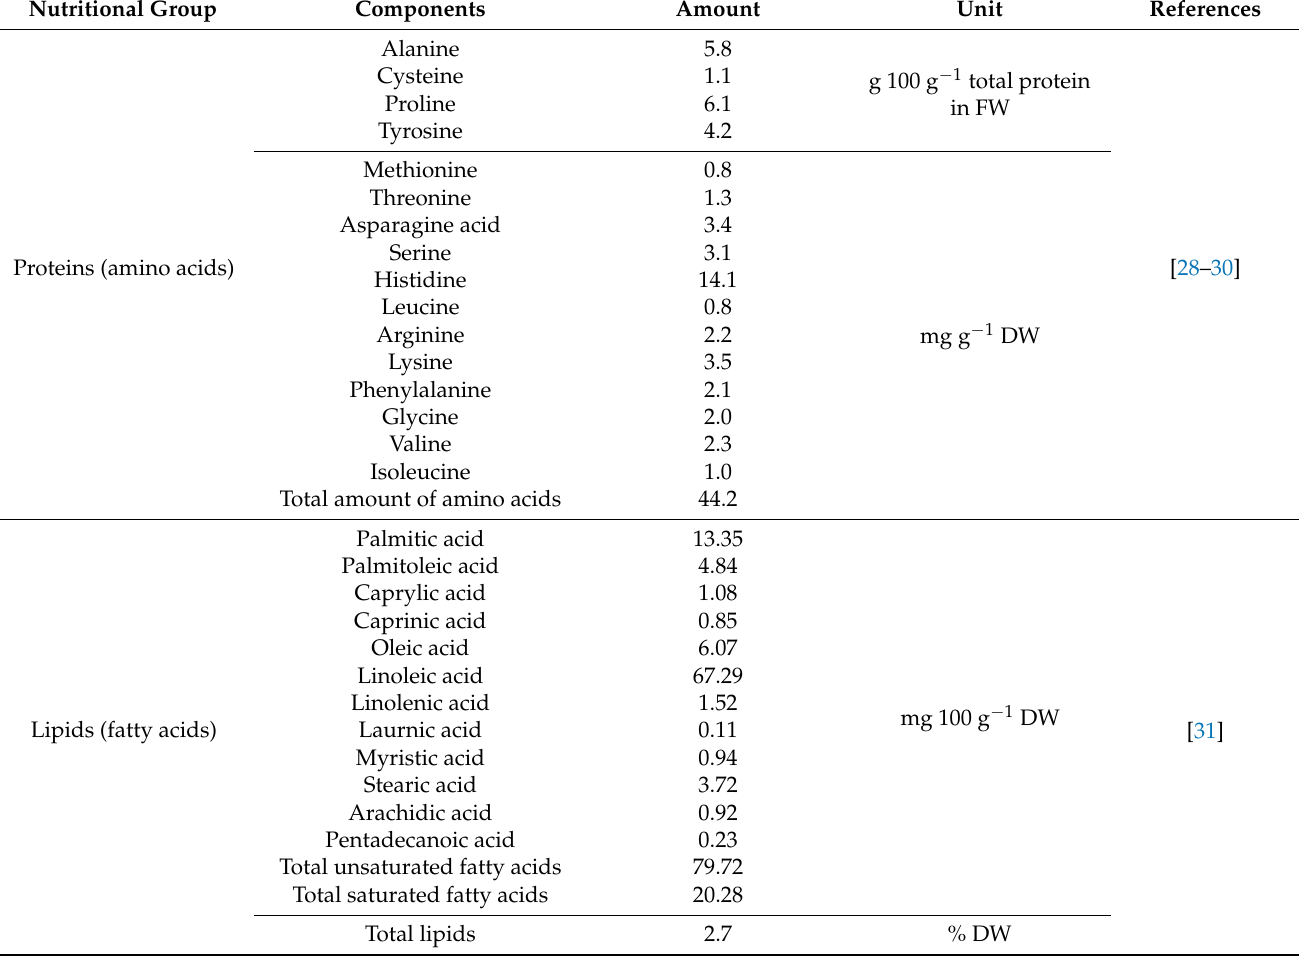
Table 2. Nutritional components present in the basidiocarp of A. bisporus